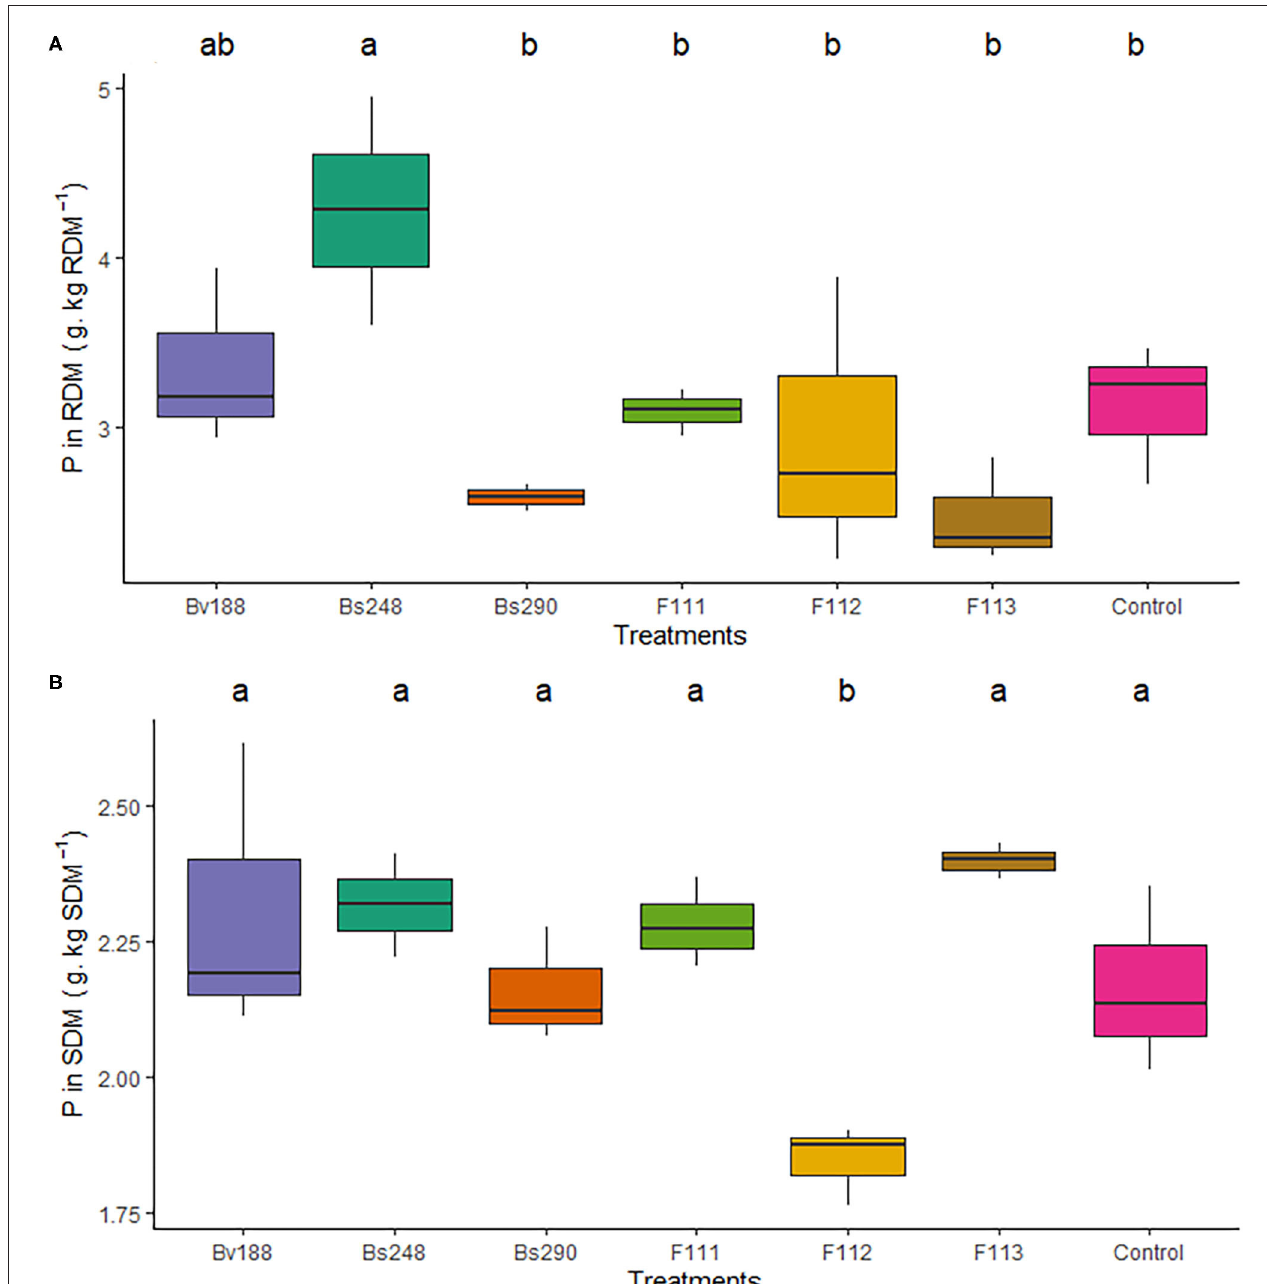
FIGURE 5 | Boxplots (median and quartiles) of P extracted in root (A) and shoot (B) total dry matter of cotton plants inoculated with the treatments. Different letters in the rows indicate significant differences between means (Duncan’s, p < 0.05). RDM, root dry matter; SDM, shoot dry matter; Bv188, Bacillus velezensis strain Bv188; Bs248, Bacillus subtilis strain Bs248; Bs290, B. subtilis strain Bs290; F111, Aspergillus brasiliensis ; F112, Aspergillus sydowii ; F113, Aspergillus sp. versicolor section; Control, no